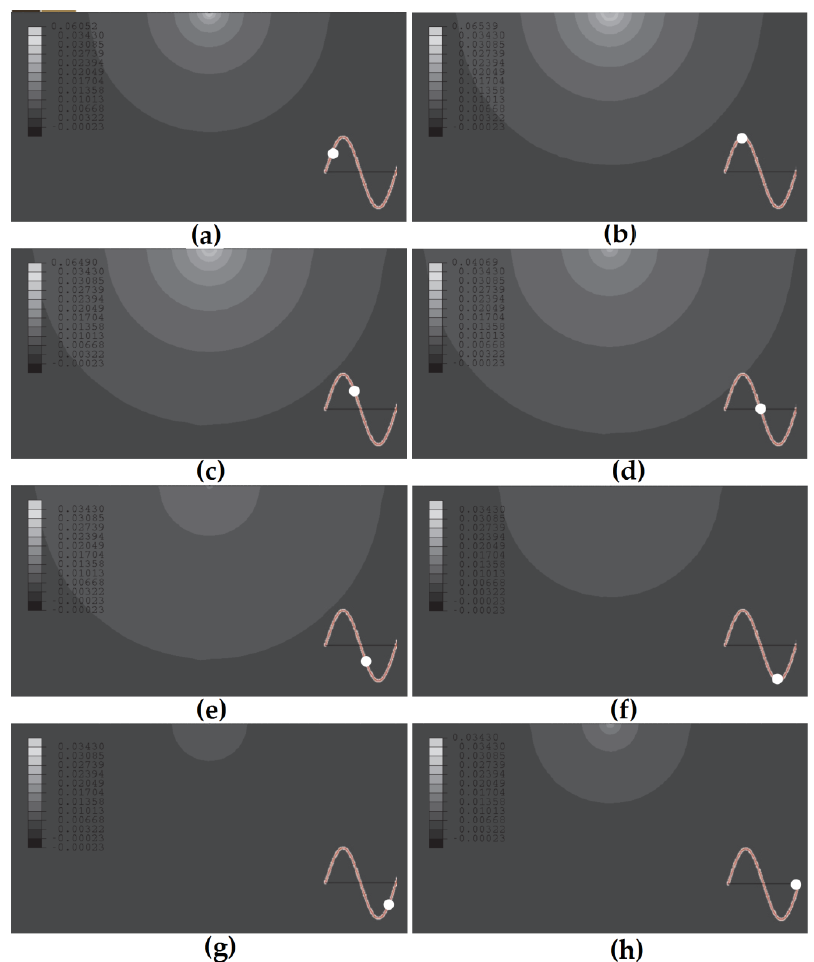
Figure 5. A typical heat penetration pattern within the bulk silicon specimen in one heating oscillation cycle ( f = 2000 Hz). ( a ) 0.0625 ms; ( b ) 0.125 ms; ( c ) 0.1875 ms; ( d ) 0.25 ms; ( e ) 0.3125 ms; ( f ) 0.375 ms; ( g ) 0.4375 ms; ( h ) 0.5 ms.